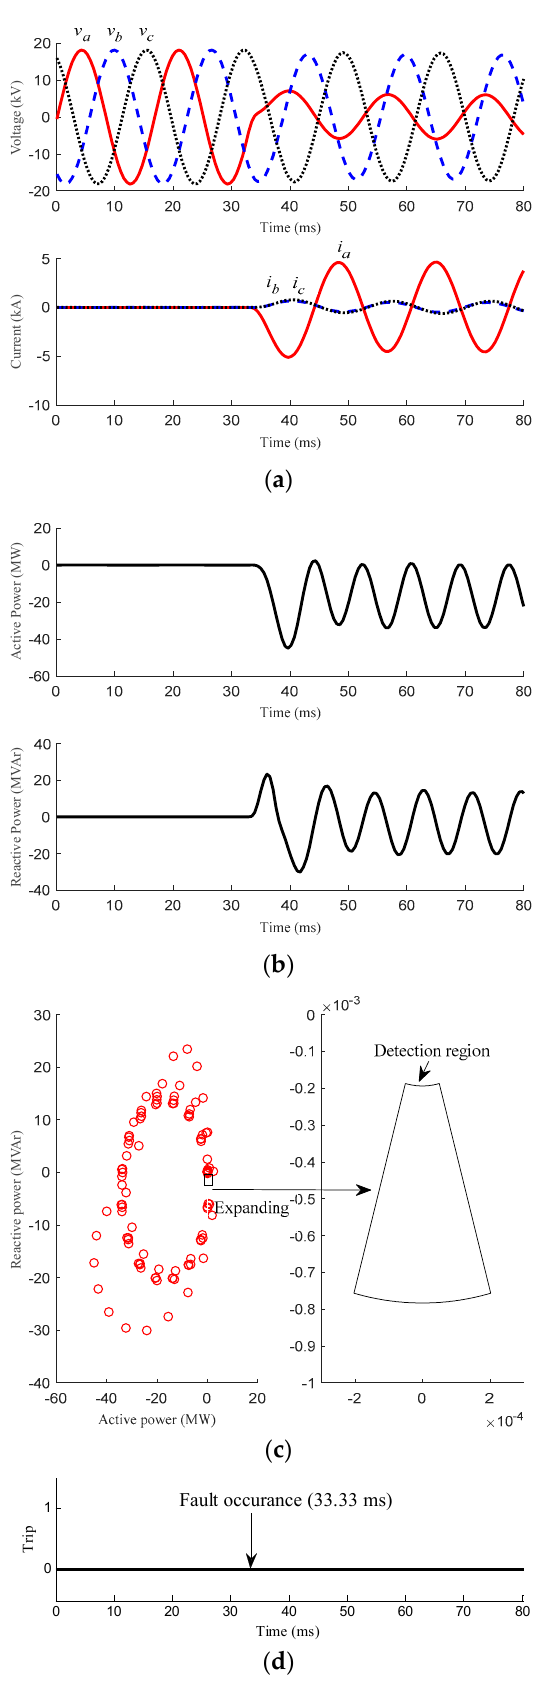
Figure 13. Results for Case 11. ( a ) v a , b , c (upper) and i a , b , c (lower); ( b ) p 3 ph (upper) and q 3 ph (lower); ( c ) Trajectories of the point ( p 3 ph , q 3 ph ); ( d ) Islanding detection signal.